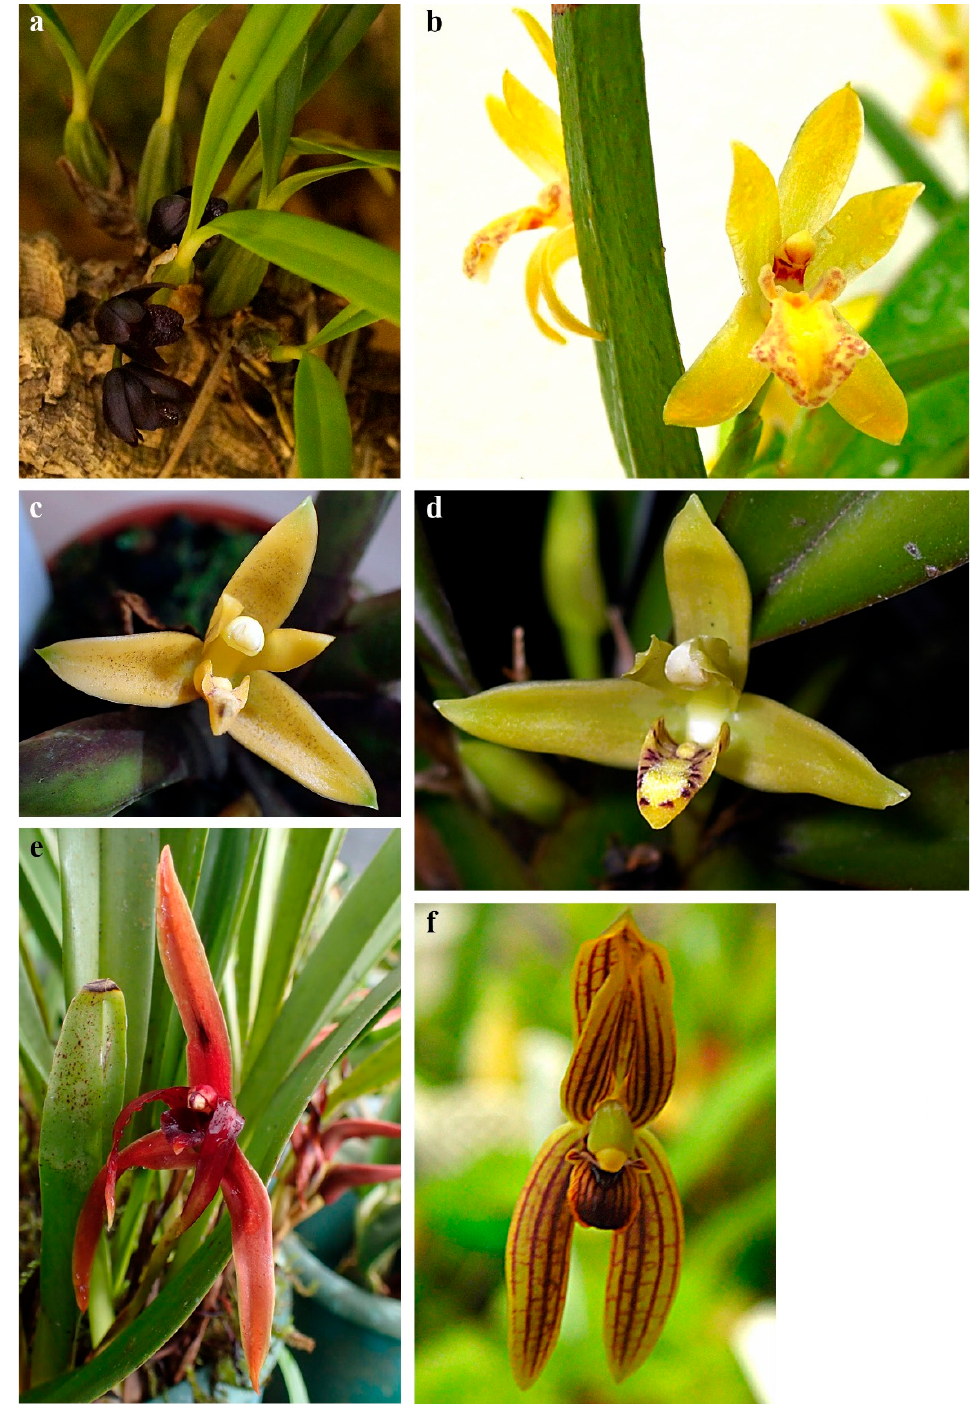
Figure 2. Flowers of Maxillariinae species examined to date: ( a ) B. schunkeana ; ( b ) Chelyella sp.; ( c,d ) Heterotaxis cf. discolor ; ( e ) Maxillaria nigrescens; ( f ) Mormolyca ringens . Photo. M. Lipi ń ska.